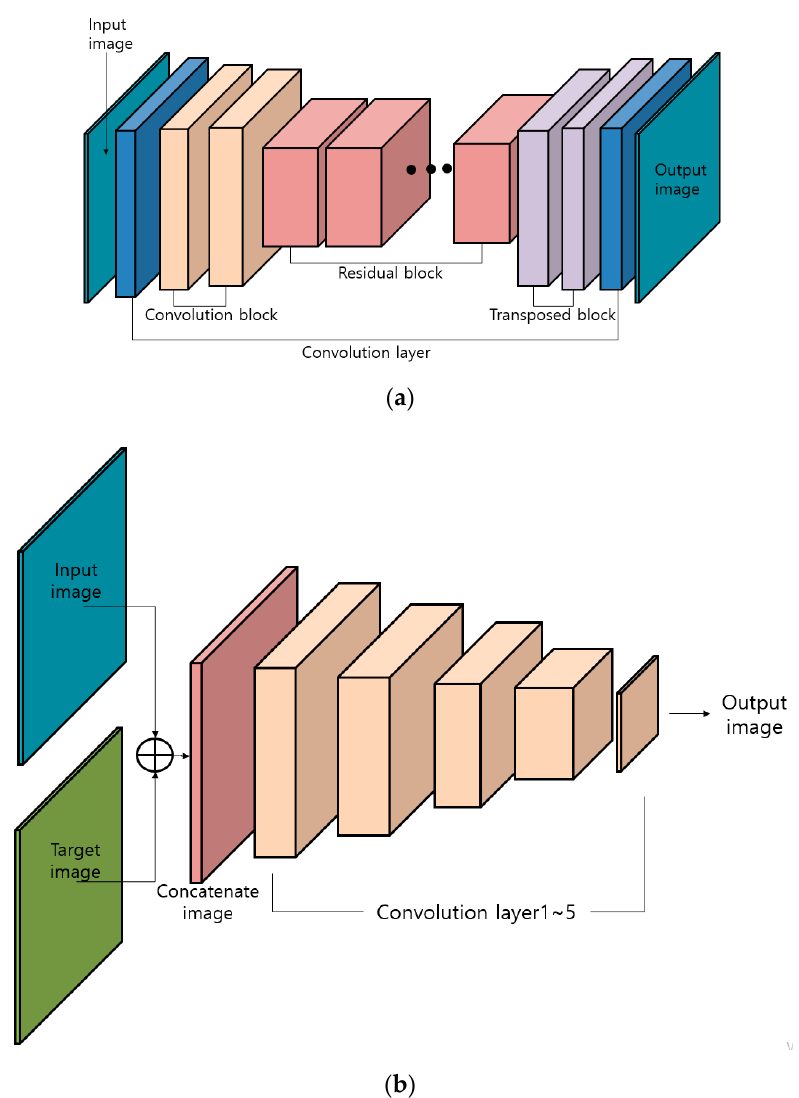
Figure 2. Architecture of DeblurGAN ( a ) Generator in DeblurGAN and ( b ) Discriminator in Figure2. ArchitectureofDeblurGAN( a )GeneratorinDeblurGANand( b DeblurGAN.